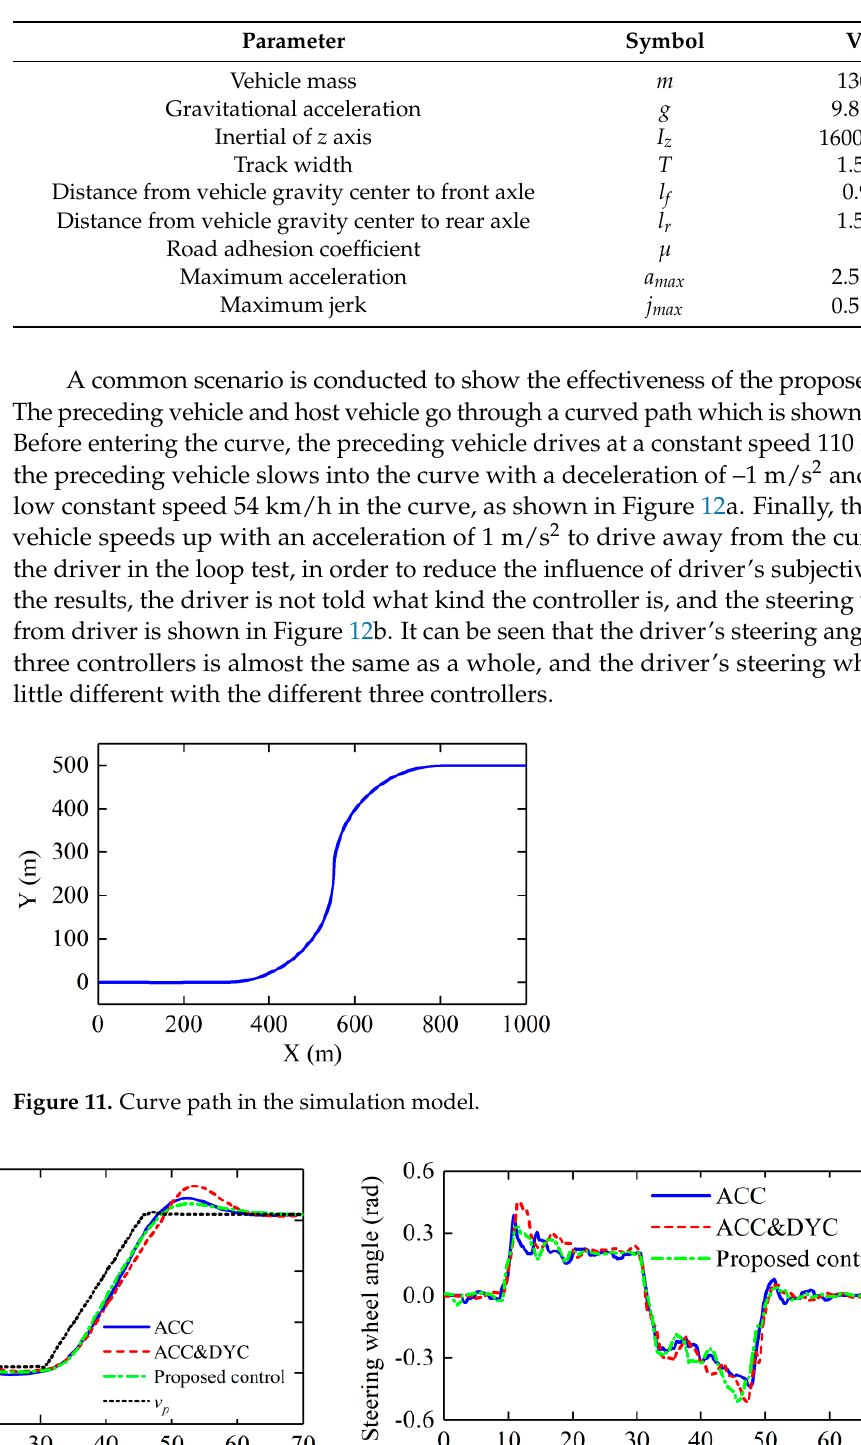
Table 1. Parameters in the simulation model.